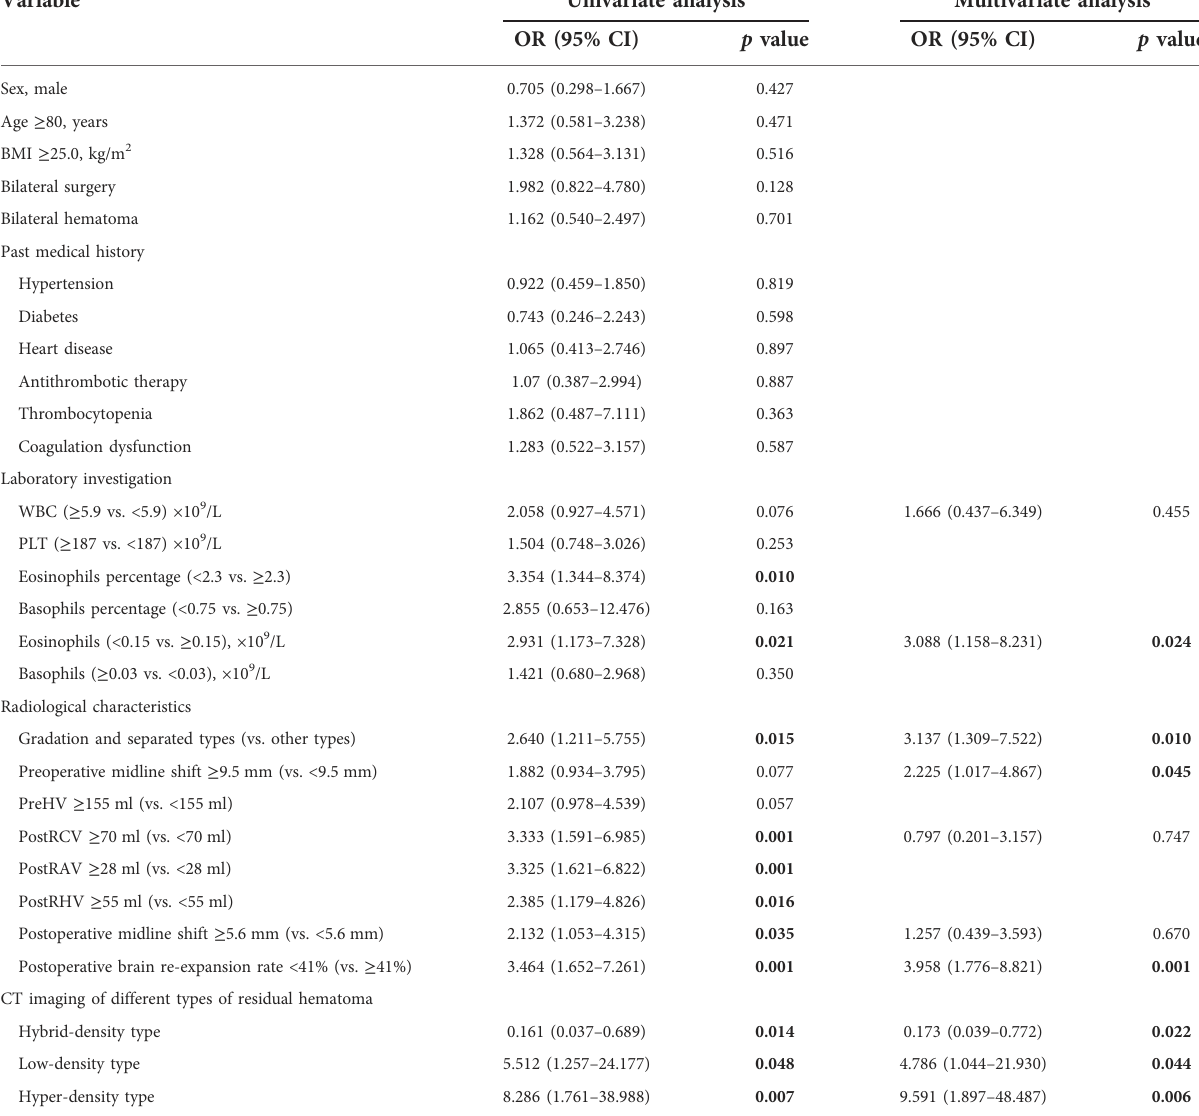
TABLE 2 Univariate and multivariate analyses of the association between CSDH recurrence and various